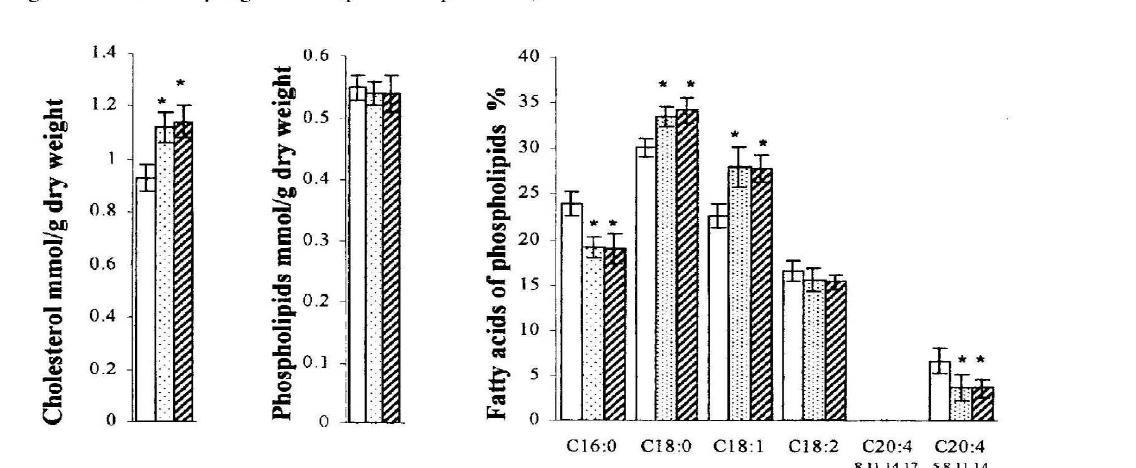
figure 3. Concentrations (mean +S.D.) of cholesterol ,md phospholipids as well as fatty acid content of phospholipids in percent; mean±S.D.) in controls (open bars) and in s'lmplcs with 4 nmoljg wet weight xanthurenic acid (dotted bars) and in samples with 40 nmoljg wet weight xanthurenic acid (hatched bars). Samples of rat liver tissue homogenates \\·ere used to test for phospholipid biosynthesis in virm. Incubation medium: Krebs - Ringer - phosphate butler containing 0.3% albumin (pH =7.4), futy acid mixnlre and glvcerol. Samples \\"ere incubated twice for 4 h at 37°C. -The changes arc statistically significant (1'<0.05 -1'<0.001 ).